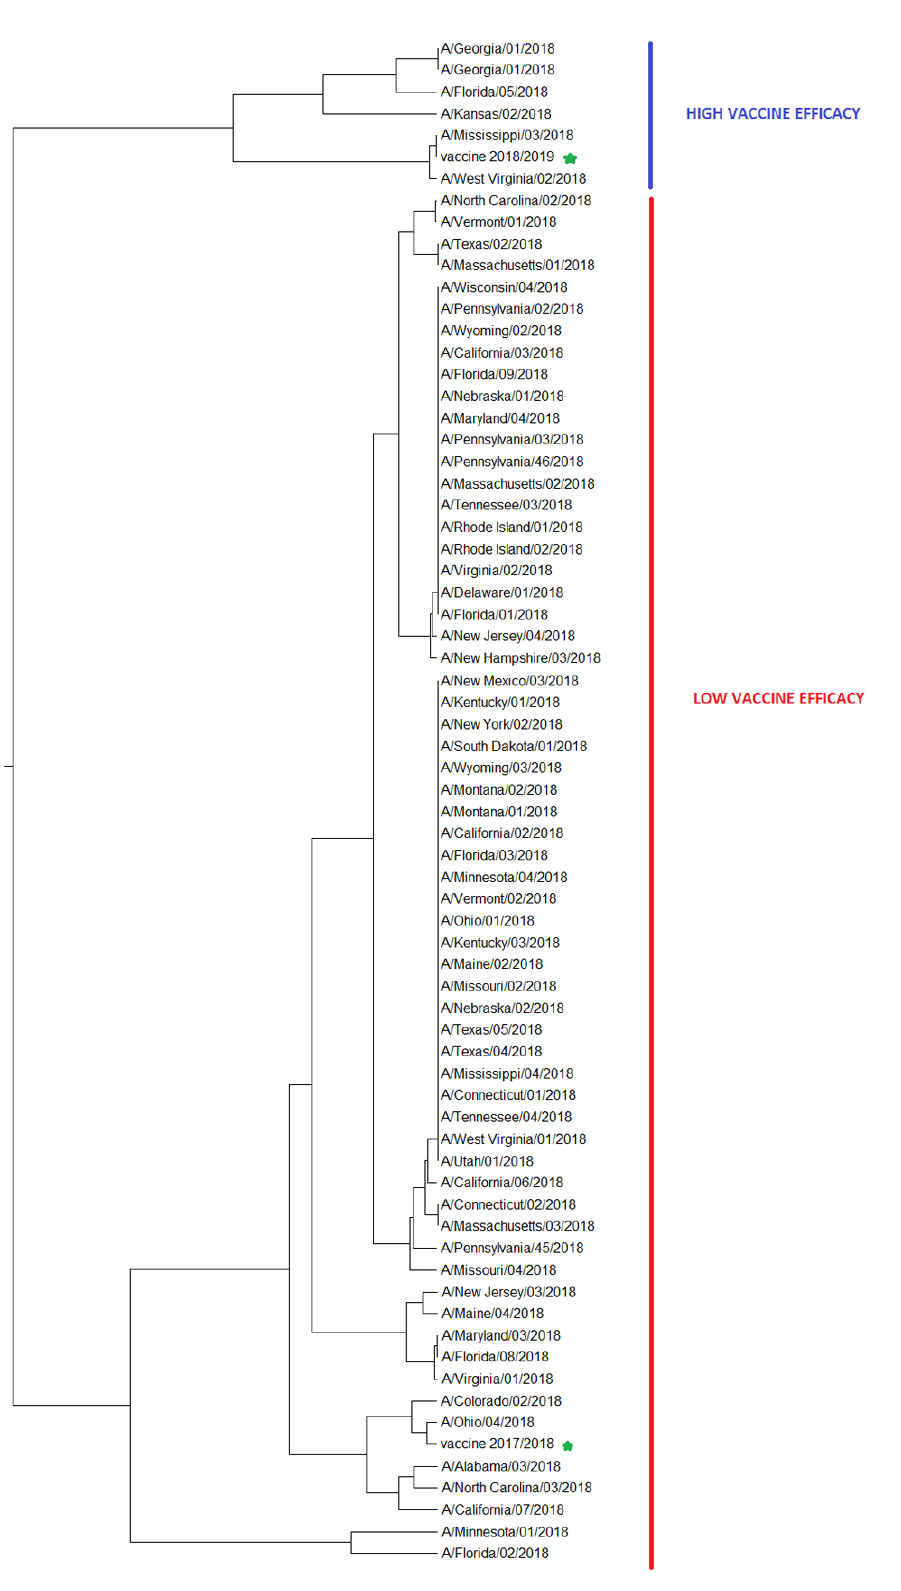
Figure 1. The ISM-based phylogenetic tree of HA1 from human H3N2 influenza viruses collected in the United States from January to February 2018. The vaccine viruses are marked with asterisk